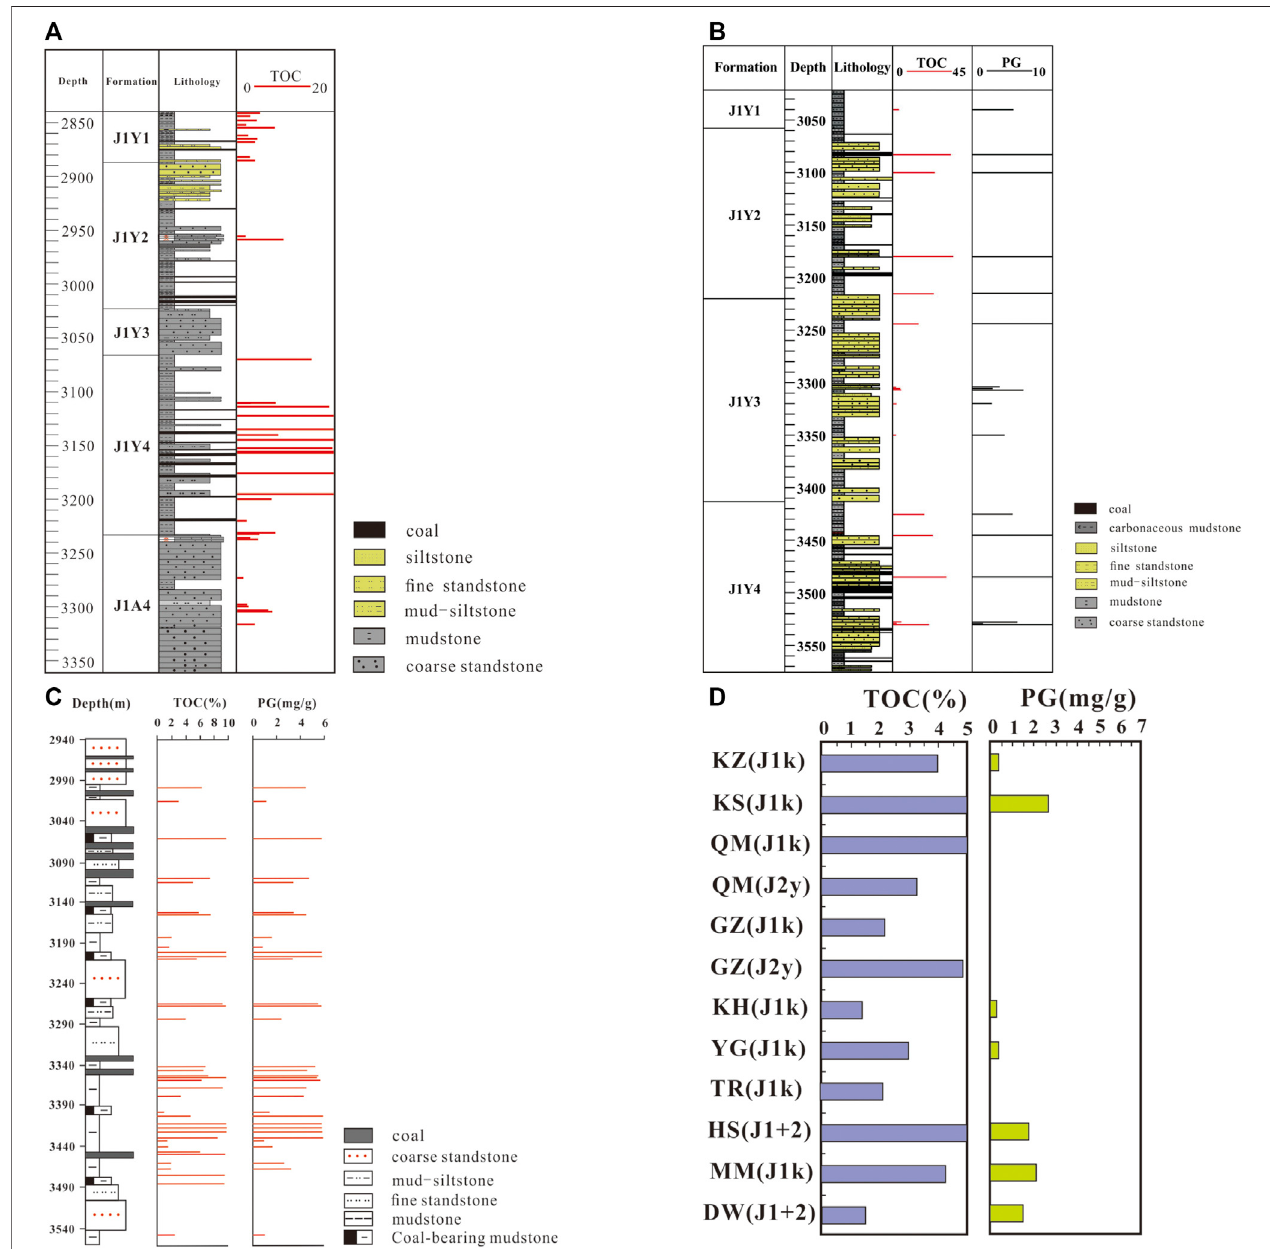
FIGURE 3 | (A) Geochemical pro fi le of Lower Jurassic shale in Kezi-1 well in the Kuqa Depression. (B) Geochemical pro fi le of Lower Jurassic shale in Yixi-1 well in the Kuqa Depression. (C) Geochemical pro fi le of Jurassic in Huayingcan-1 well in the East Tarim area. (D) Geochemical pro fi le of Lower Jurassic shale outcrop in